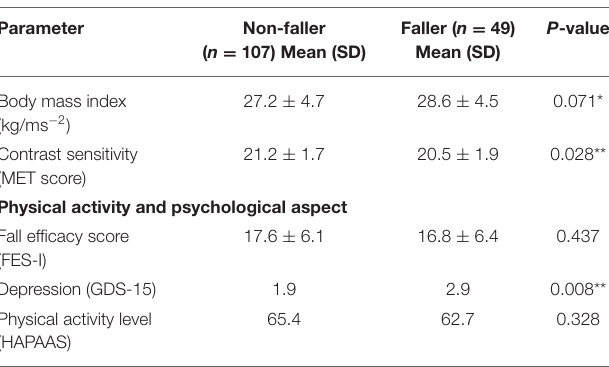
TABLE 4 | Univariate analysis of physical and psychological condition of participants according to fall status. Parameter